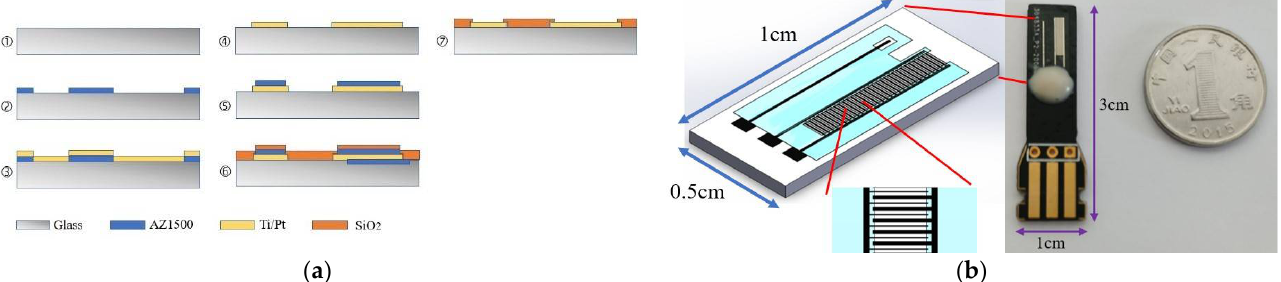
Figure 1. Ultramicro interdigital array electrode chip: ( a ) fabrication process; ( b ) schematic and picture of the electrode chip.